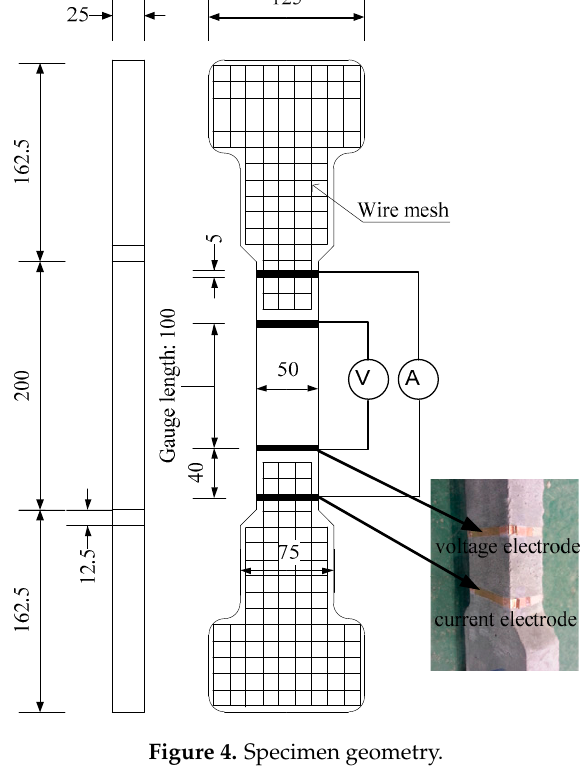
Figure 4. Specimen geometry.